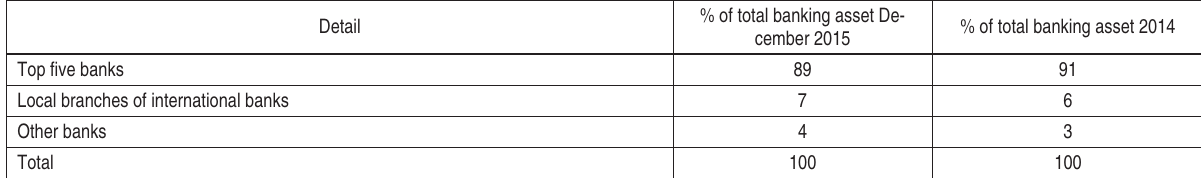
Table 1. Total asset structure in the South African banking